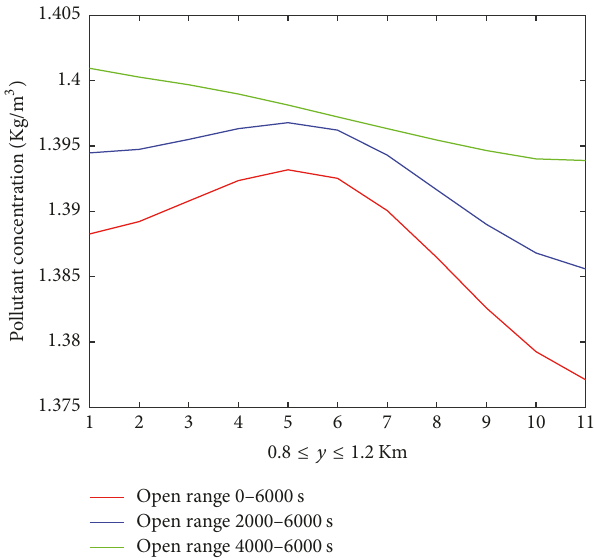
Figure 12: Comparison of approximated pollutant concentrations along the southern part, 𝐶(𝑥,𝑦,𝑡) , for all 0 ≤ 𝑥 ≤ 2000 m, 𝑦 = 800 m, and 0 ≤ 𝑡 ≤ 100 min, when the first, second, and third zonal removal mechanism systems are activated.